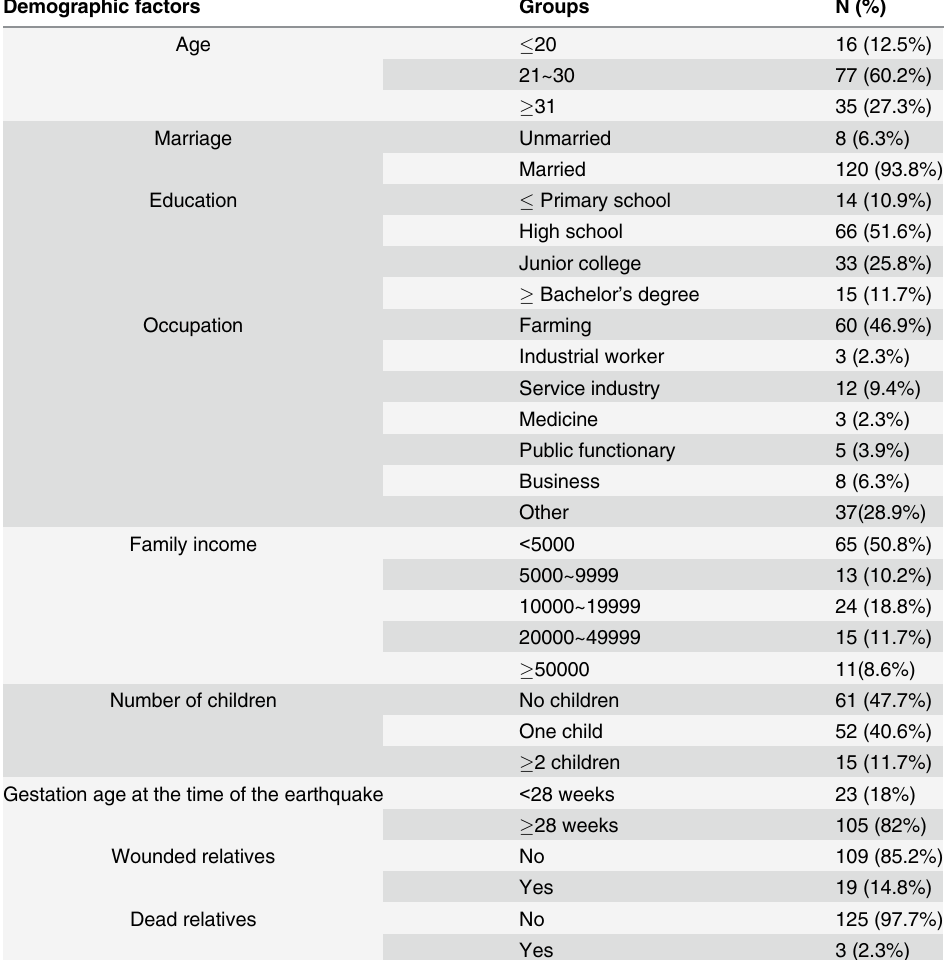
Table 2. Demographics, EPDS scores, social support, and coping styles of women who participated in the study (n = 128). Demographic